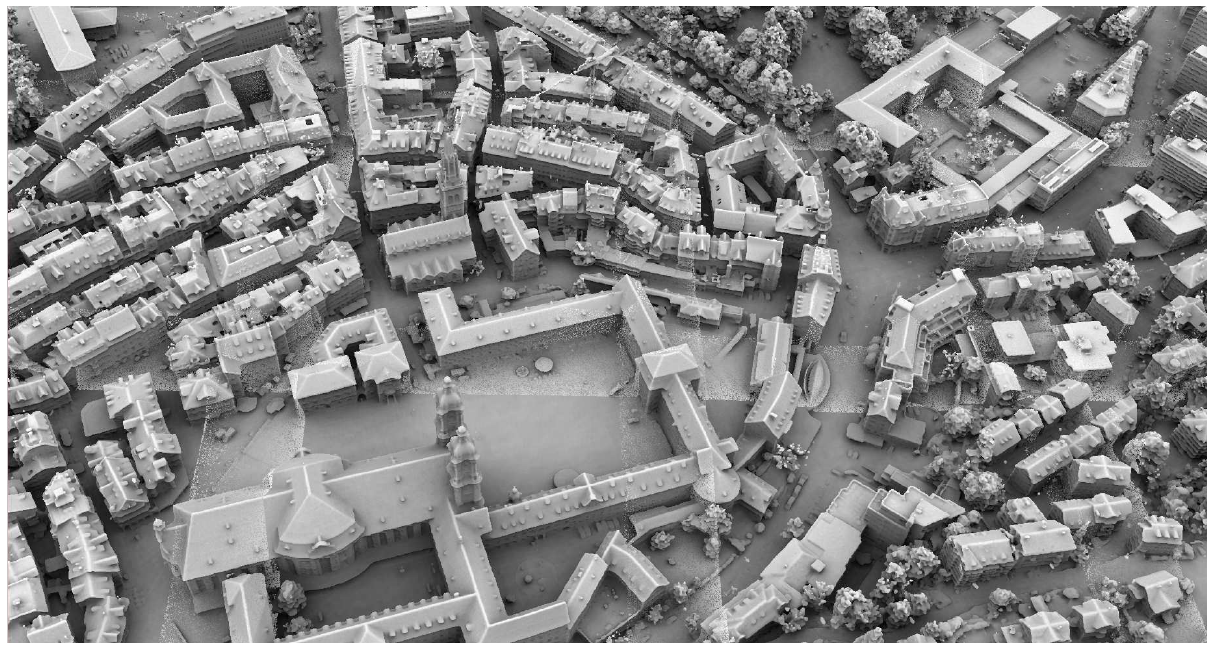
Figure 10: Larger part of the mesh generated from the airborne oblique data set. Visible tile overlaps are due to shading and not to variances in